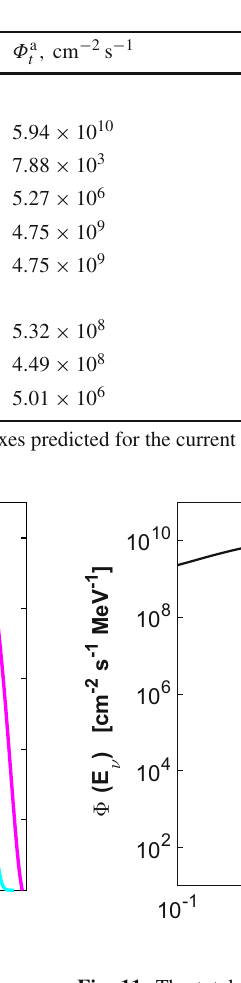
Fig. 10 Normalised sterile neutrino spectra for the Sun: pp (yellow curve), 8 B (cyan curve), Be 7 (red curve) hep (magenta curve) N 13 (blue curve), O 15 and F 17 (green curve)